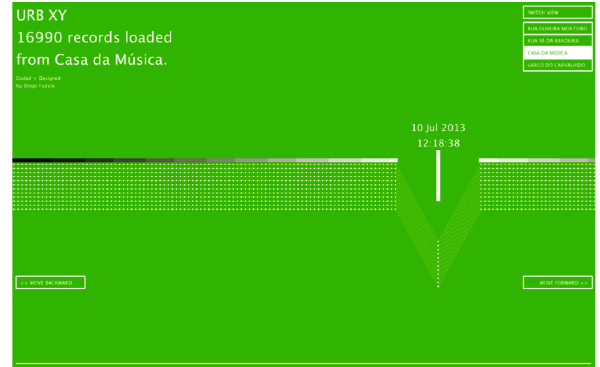
Figure 7 | URB XY starting interface.